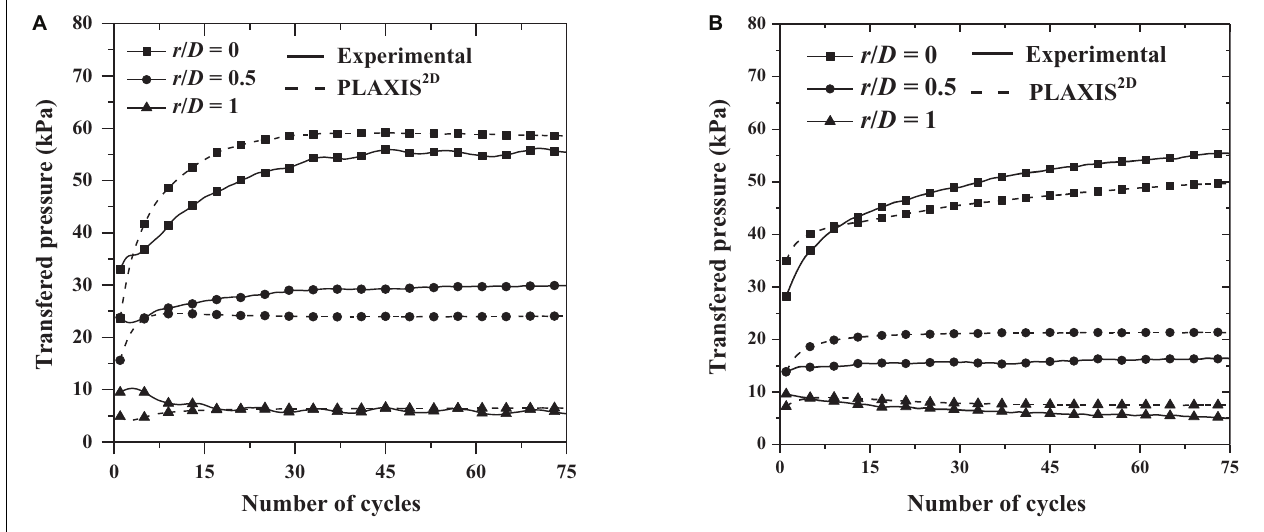
FIGURE 11 | Comparison of experimental and numerical transferred pressures: (A) unreinforced subgrade; (B) geocell with a basal geogrid reinforced subgrade.